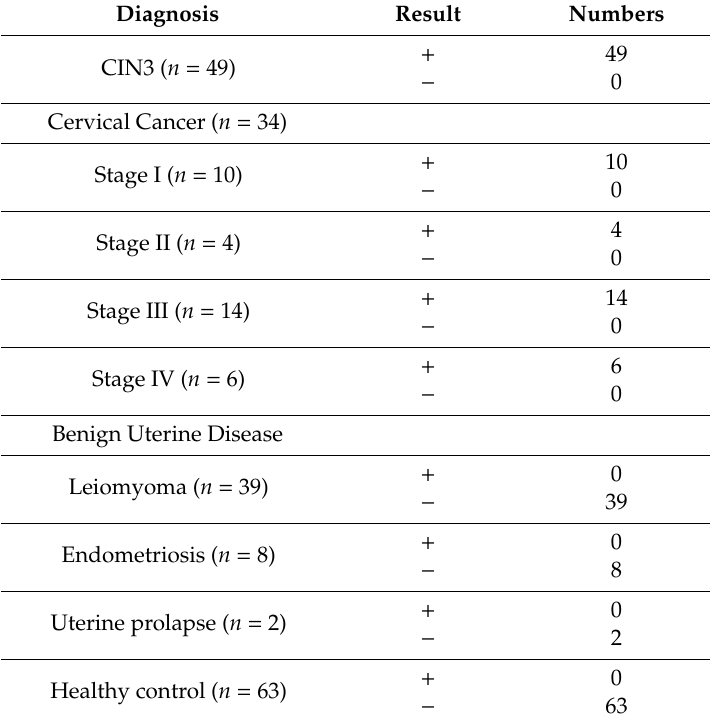
Table 3. Results from canine scent detection of urine samples from di ff erent patient